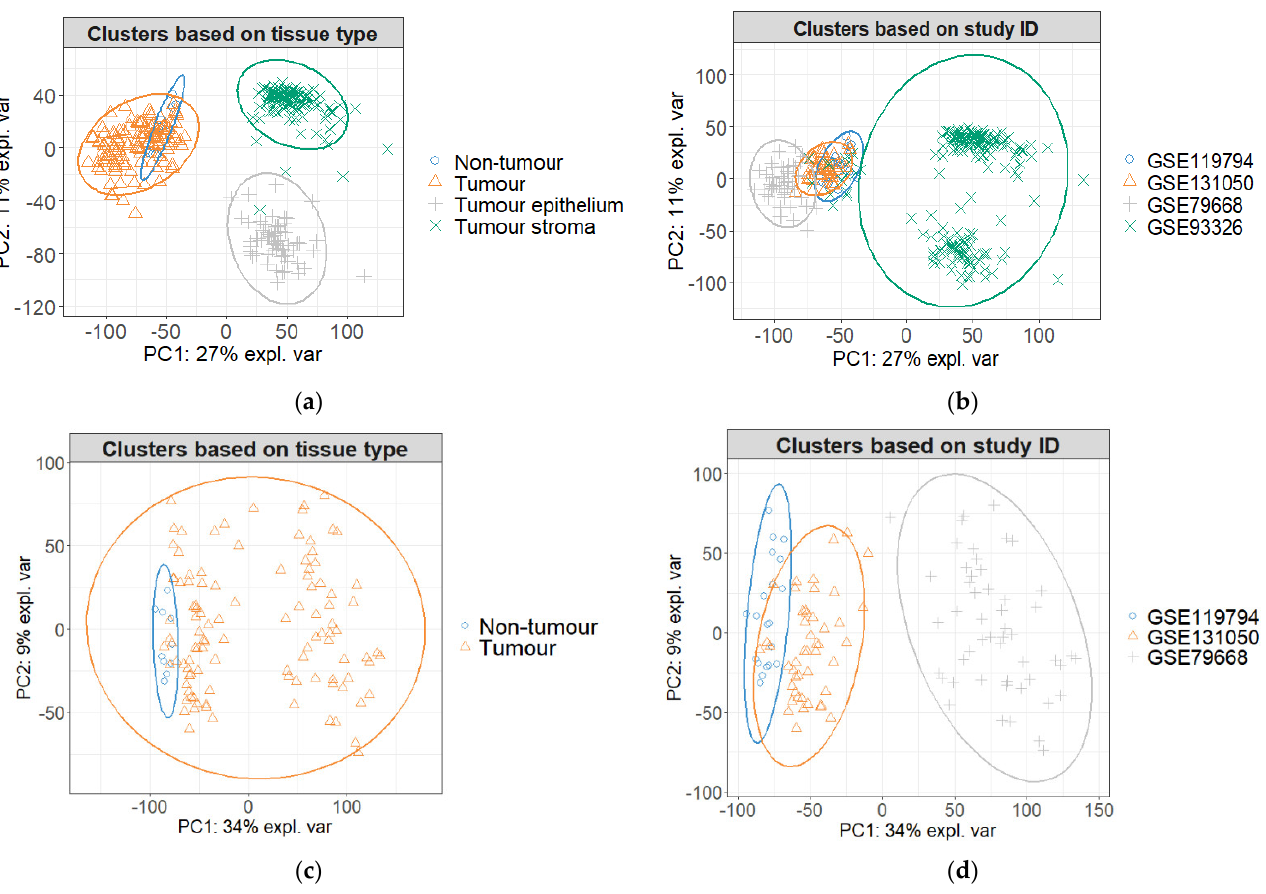
Figure A3. Unsupervised segregation of the collated datasets using Principal Component Analysis. Segregation of ( a ) all datasets based on tissue type (tumour = 123, non-tumour = 10, tumour epithe- lium = 66, and tumour stroma = 123); ( b ) all datasets based on the GEO accession number; ( c ) all datasets excluding GSE93326 based on the tissue type (tumour = 108 and non-tumour = 10); and ( d ) all datasets, excluding GSE93326, based on the GEO accession number.